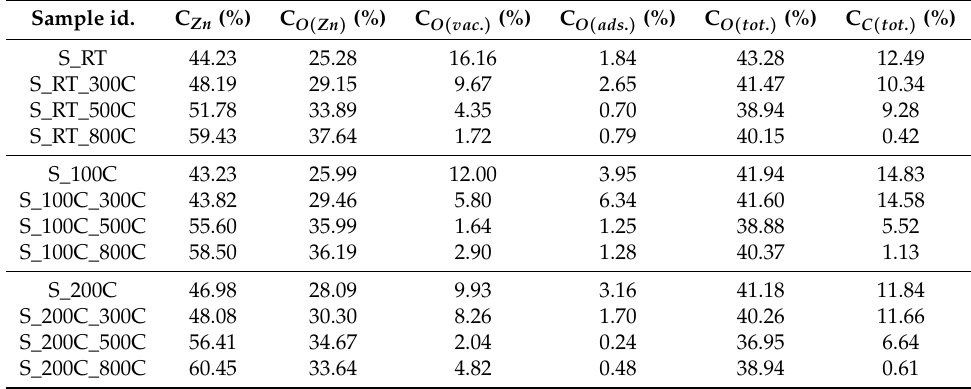
Table 5. Concentration of detected elements (Zn, O and C) at the surface of the produced layers as well as the ratio of Zn to O atoms.